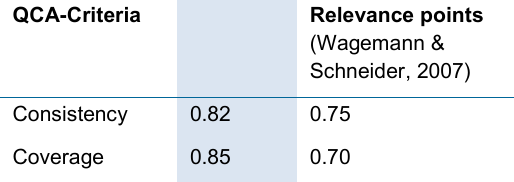
Table 4: QCA Criteria Other independent variables like gender (male, female) or whether someone worked in the factory or in marketing were checked but had no significant influence on the transfer of responsibility; even combinations like ‘female marketing staff with high attendance quota and participation between one and three years’ did not result in a higher likelihood of responsibility